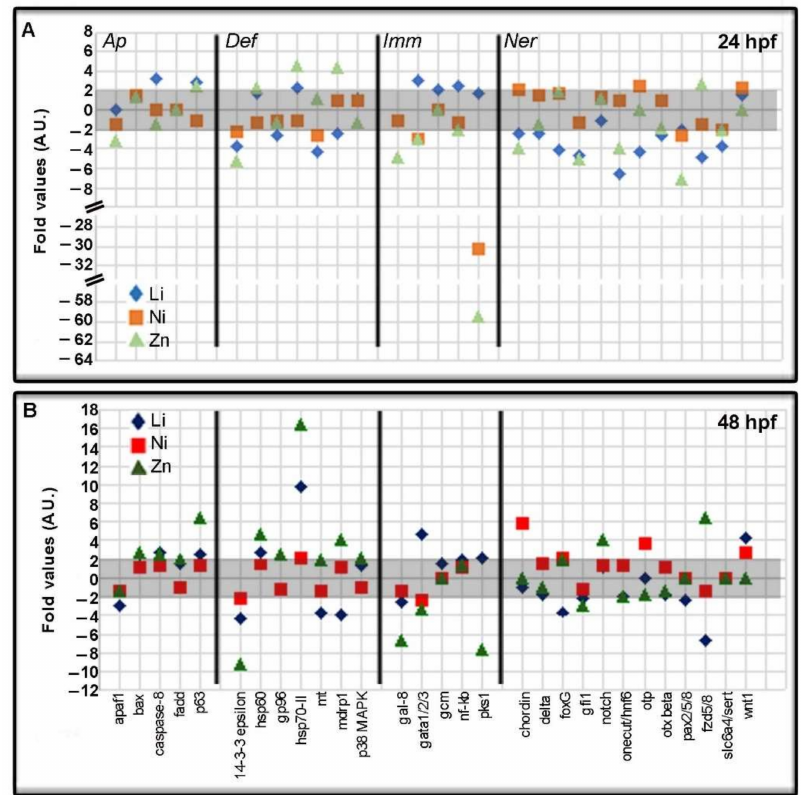
Figure 4. Apoptosis, Defense, Immune, and Nervous genes are modulated by Li, Ni, and Zn treatments. The grey boxes indicate the threshold for insignificant changes following Li, Ni, and Zn treatments, i.e., fold values between − 2 and + 2 at 24 ( A ) and 48 ( B ) hours post-fertilization (hpf). Symbols in the plot at 24 hpf ( A ): light blue rhombus, Li-embryos; orange square, Ni-embryos; light green triangle, Zn-embryos. Symbols in the plot at 48 hpf ( B ): blue rhombus, Li-embryos; red square Ni-embryos; green triangle, Zn-embryos. Ap , Apoptosis genes; Def , Defense genes; Imm , Immune genes; Ner , Nervous